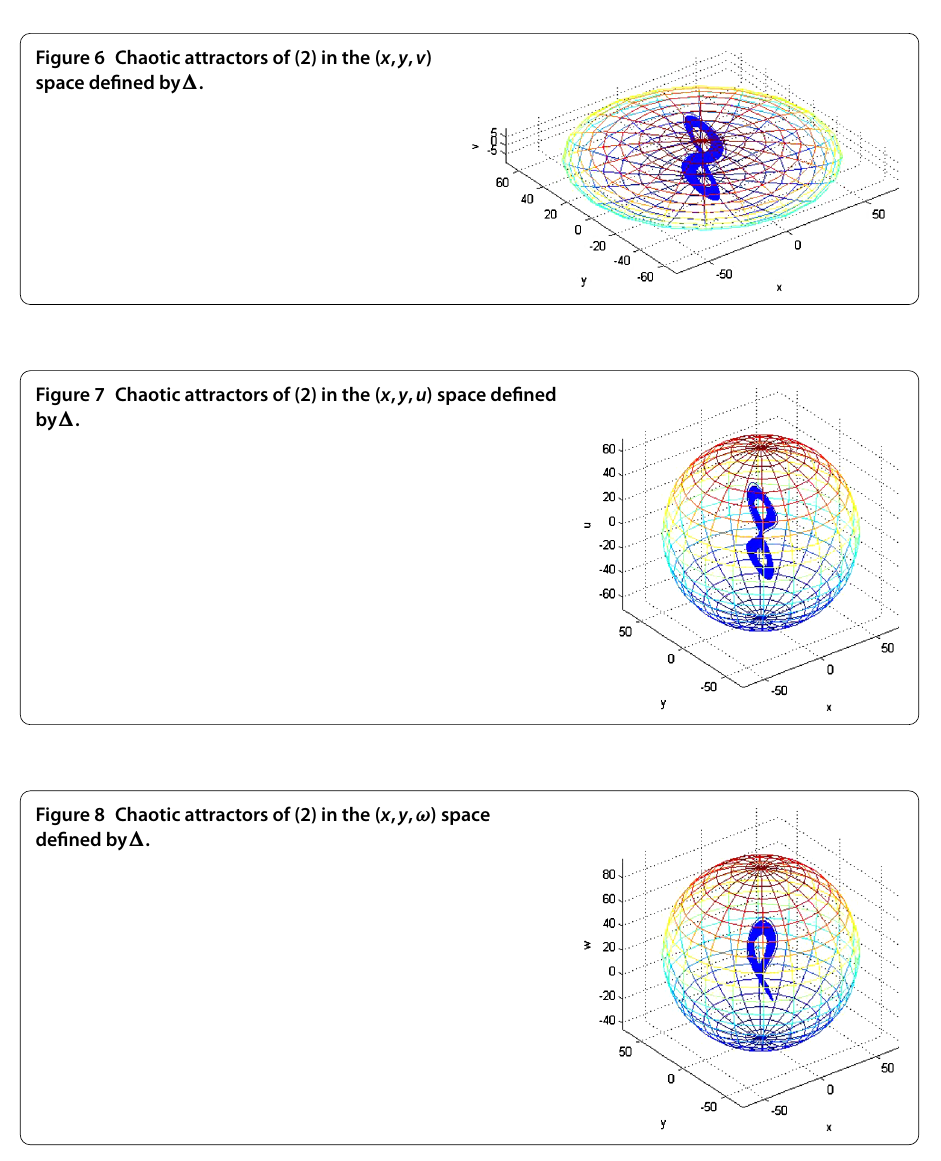
chaotic attractors of system () in the ( x , y , v ) space defined by (cid:9) in (). Figure shows chaotic attractors of system () in the ( x , y , u ) space defined by (cid:9) in (). Figure shows chaotic attractors of system () in the ( x , y , ω ) space defined by (cid:9) in